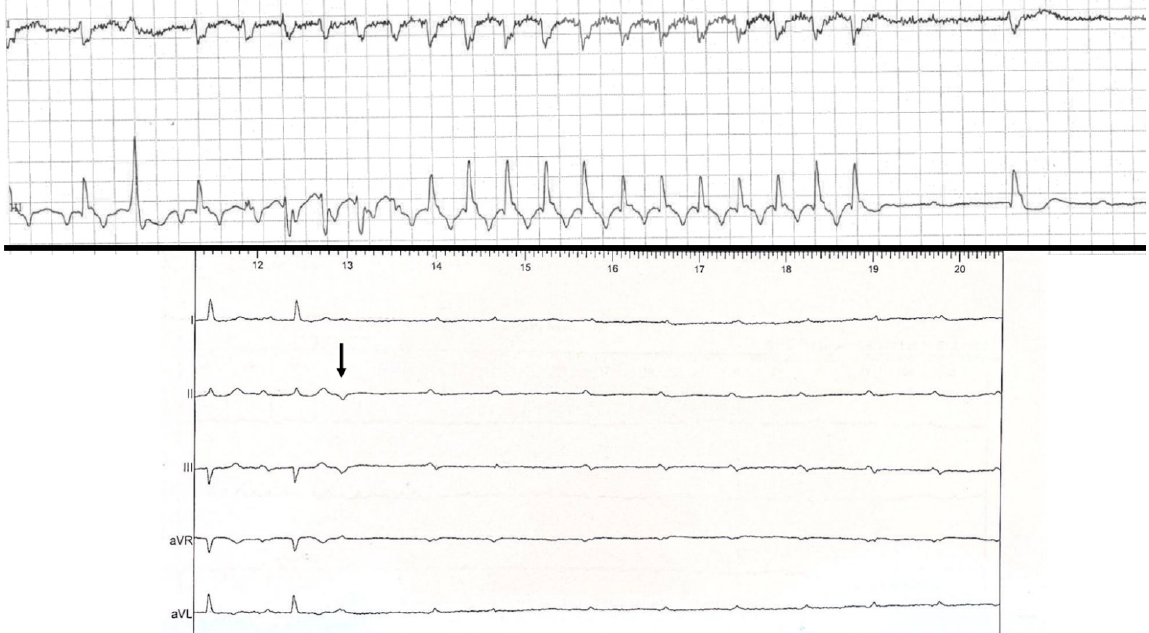
Figure 3. Example of two mechanisms of pause-dependent atrioventricular block seen within the same patient (patient 10 in Table 2). Baseline twelve-lead ECG shows sinus rhythm with complete left bundle branch block and a conducted premature atrial contraction (PAC). Another timely-ap- propriate PAC then induced PD-AVB (left lower image). Another PD-AVB episode was recorded after a premature ventricular contraction (lower right image). flutter. 5 SR: sinus rhythm.